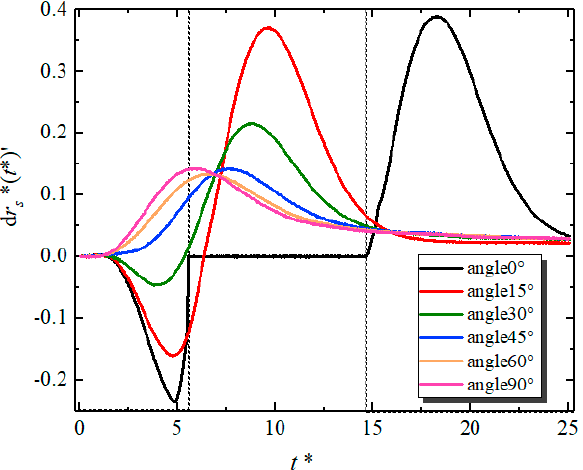
Figure 13. Derivative of surface-to-surface distance to time as functions of time.